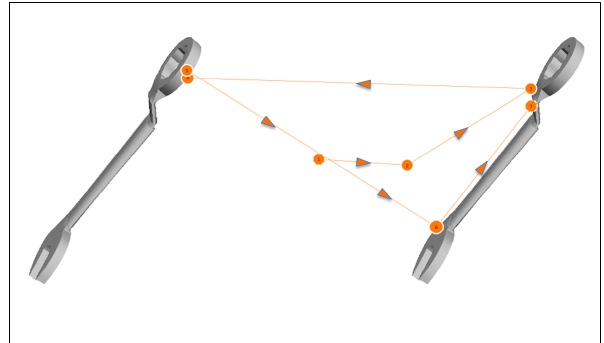
Figure 3: Gaze pattern 1 – Analytic Gaze Pattern 2: In the second gaze pattern (Figure 4), direction in which the AOIs are scanned can be different.